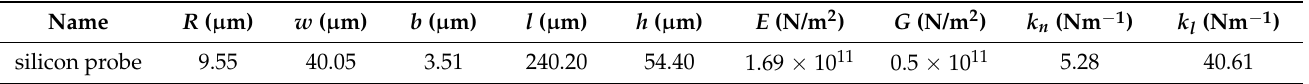
Table 4. Physical parameters of the silicon spherical probe used in this work.